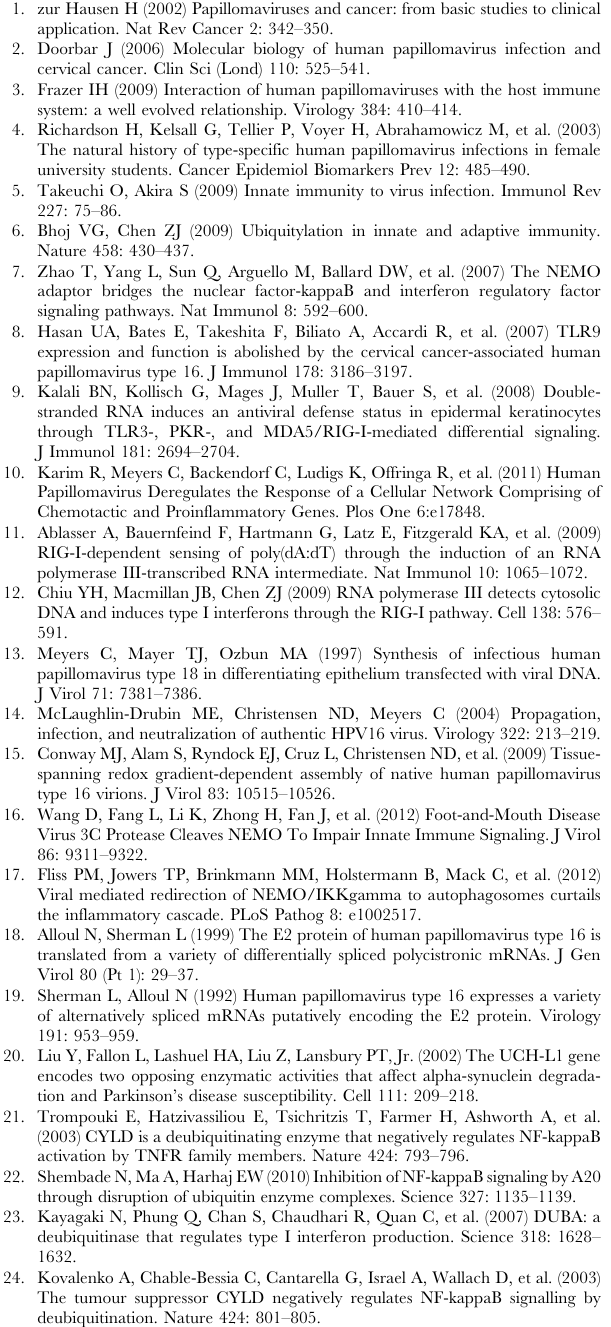
Figure S4 TRAF3 and NEMO are deubiquitinated by UCHL1. HEK293T cells were co-transfected with HA-tagged wild-type ubiquitin (WT-Ub) only, with Flag-TRAF3 and HA- tagged wild-type ubiquitin (WT-Ub), and with Flag-TRAF3 and HA-tagged wild-type ubiquitin (WT-Ub) and UCHL1. A similar experiment was performed in which Flag-TRAF3 was replaced by Flag-NEMO (top panels). The bottom four panels show a WB analysis of Flag,Wt-Ub, and UCHL1 of non- immunoprecipitated lysate and a Ponceau S stained loading control for WB.